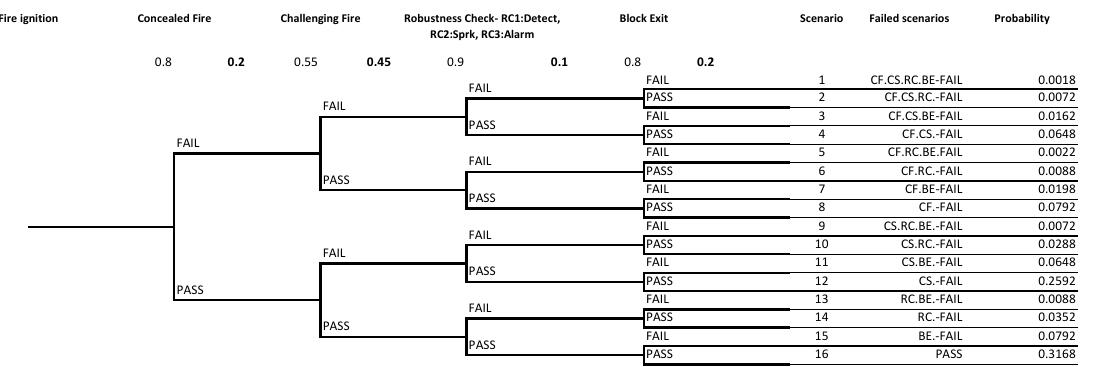
Figure A1. Example of a typical Event tree incorporating fire